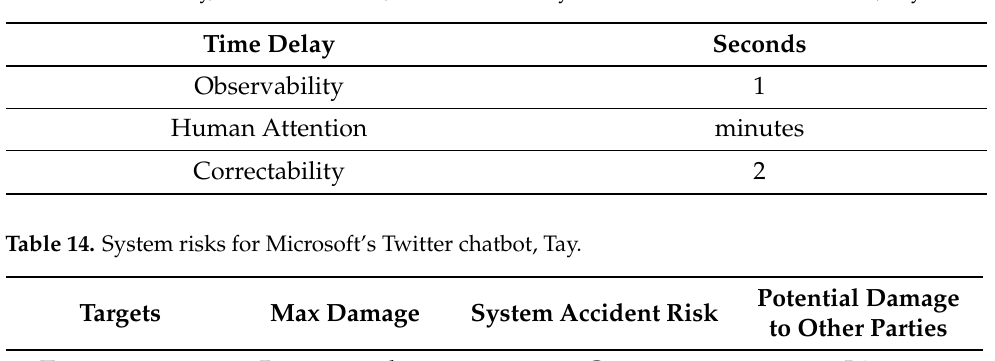
Table 13. Time delay, human attention, and correctability for Microsoft’s Twitter chatbot, Tay.